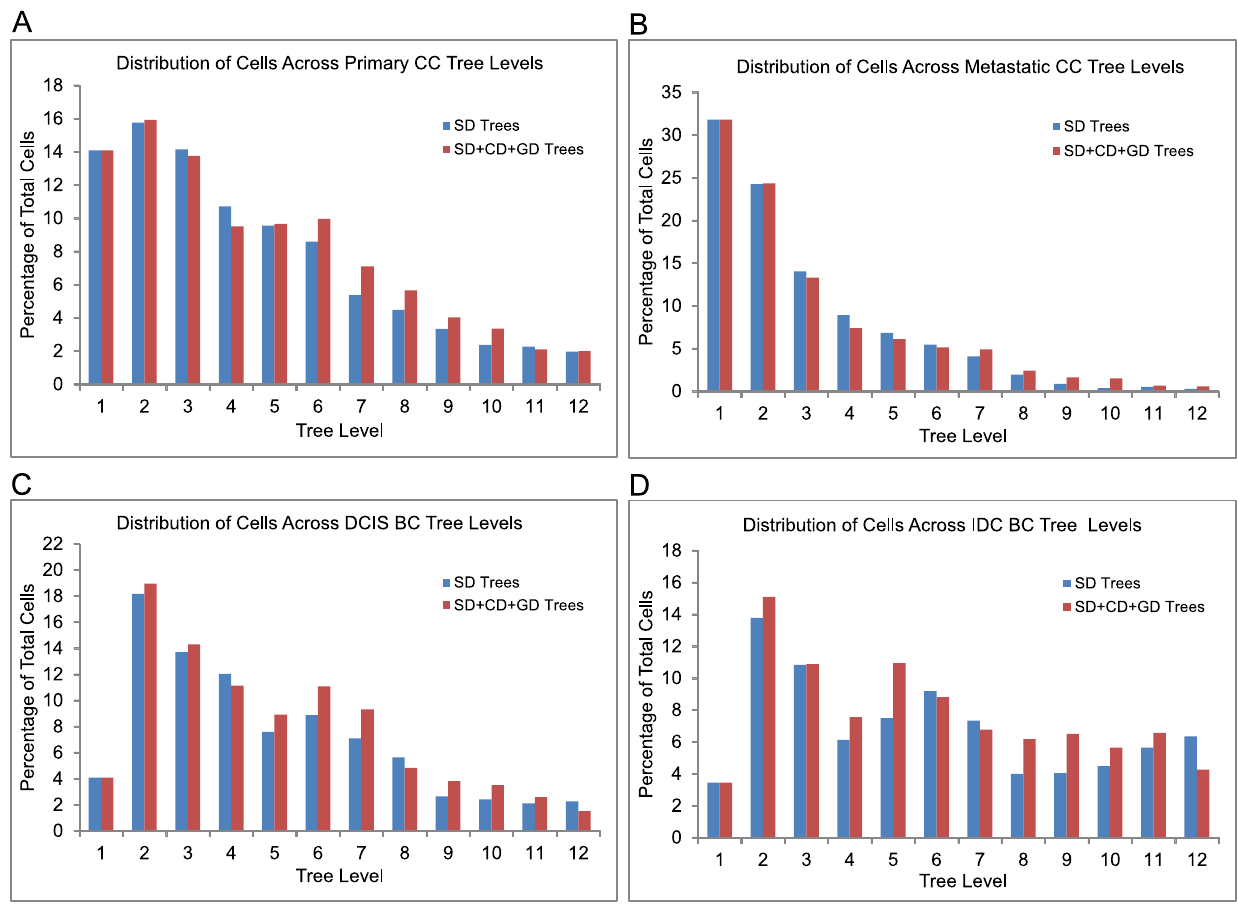
Figure 7. Distribution of cells across different levels of tumor phylogenies. Distribution of cells across different levels are shown for (A) Primary and (B) Metastatic CC, and (C) DCIS and (D) IDC BC tumor progression trees.